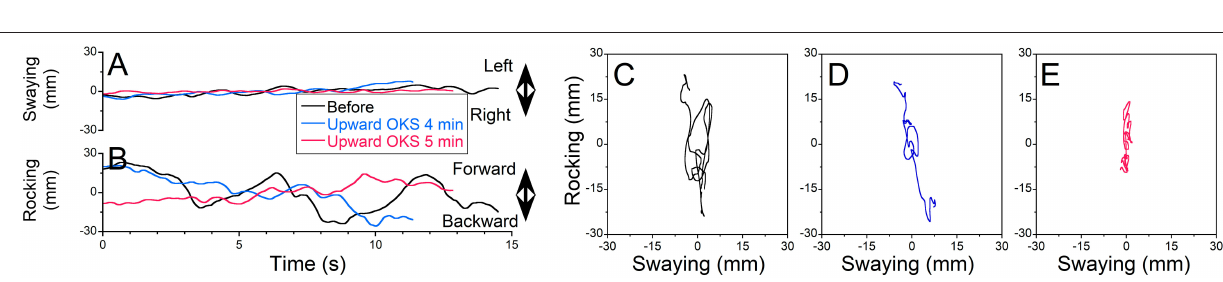
FIGURE 1 | Overall symptom severity self-scores before and after readaptation treatment in five patients. (A–E) Scores after individual treatments in each patient. (F) Overall symptoms score obtained before, after and on follow-ups.